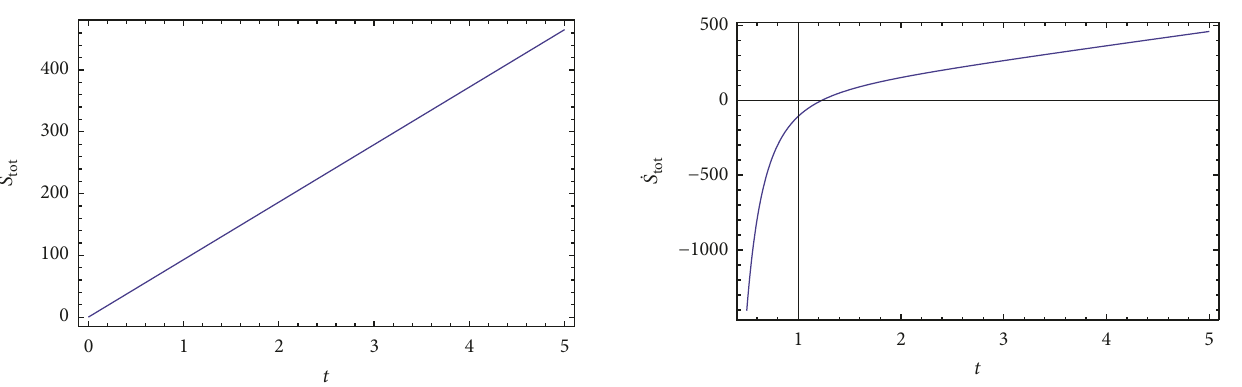
̇𝑆 Figure 3: Plot of tot by taking Logarithmic entropy as entropy at apparent horizon, where time is measured in